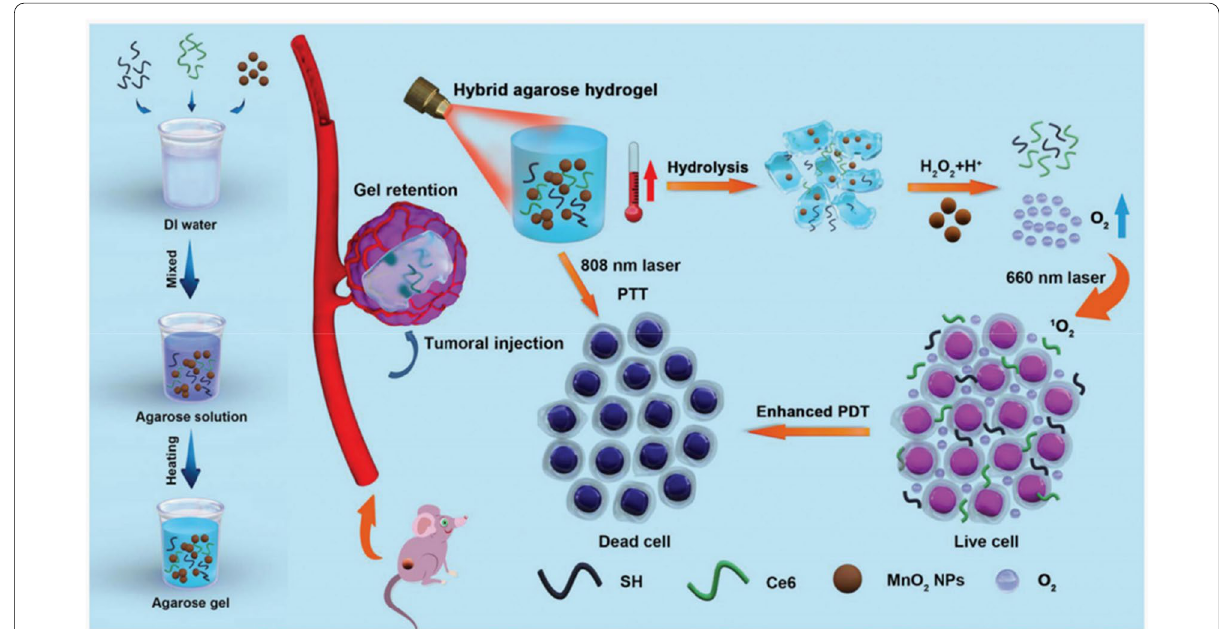
Fig. 4 Schematic diagram of the synthesis process and working principle of the agarose@SH/MnO 2 /Ce6 hydrogel. Effective tumor inhibition was accomplished through enhanced photo-induced tumor therapy on the basis of the relief of tumor hypoxia [53]. Copyright 2020 Biomater